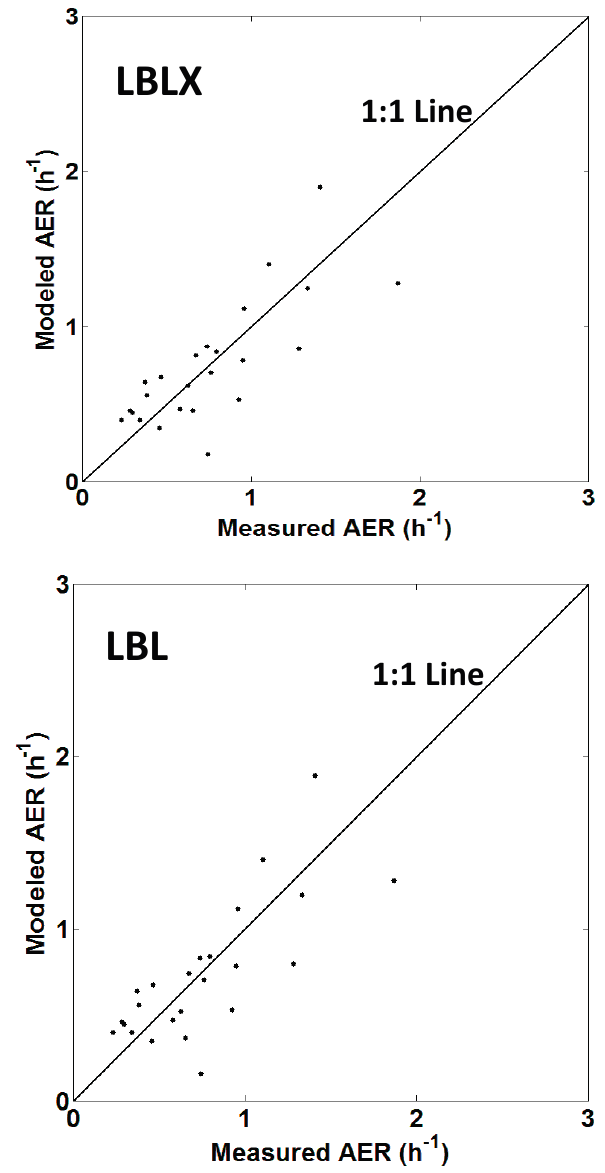
Figure 1. Scatter plots of the LBLX ( top ) and LBL ( bottom ) model-predicted and measured AER for each home. The points are average AER values for each home. Points above and below the 1:1 line indicate model overestimation and underestimation, respectively.